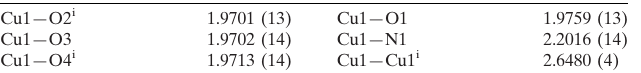
Selected bond lengths (A˚ ).